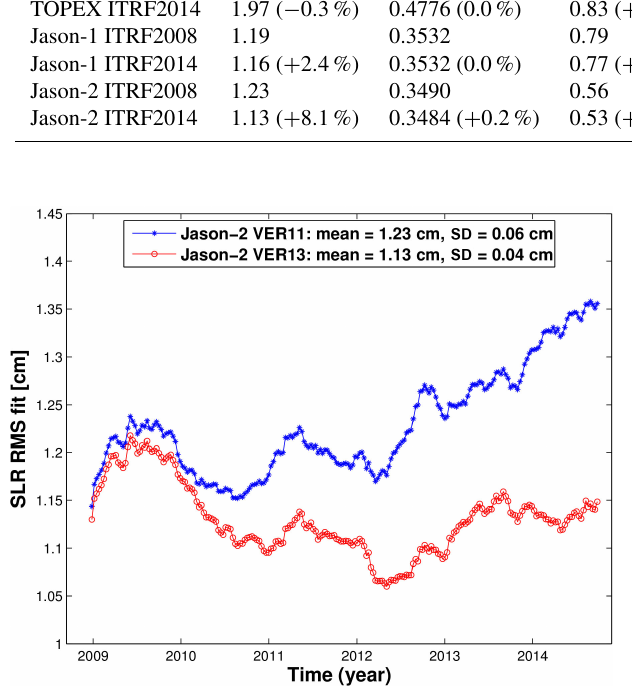
Figure 2. Fifty-two-week running mean of the rms fits of Jason-2 SLR observations obtained using ITRF2014 (VER13 orbit) and ITRF2008 (VER11 orbit) from 5 July 2008 to 6 April 2015. SD denotes standard